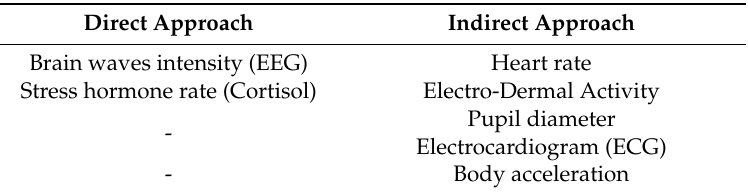
Table 1. Biometrical data